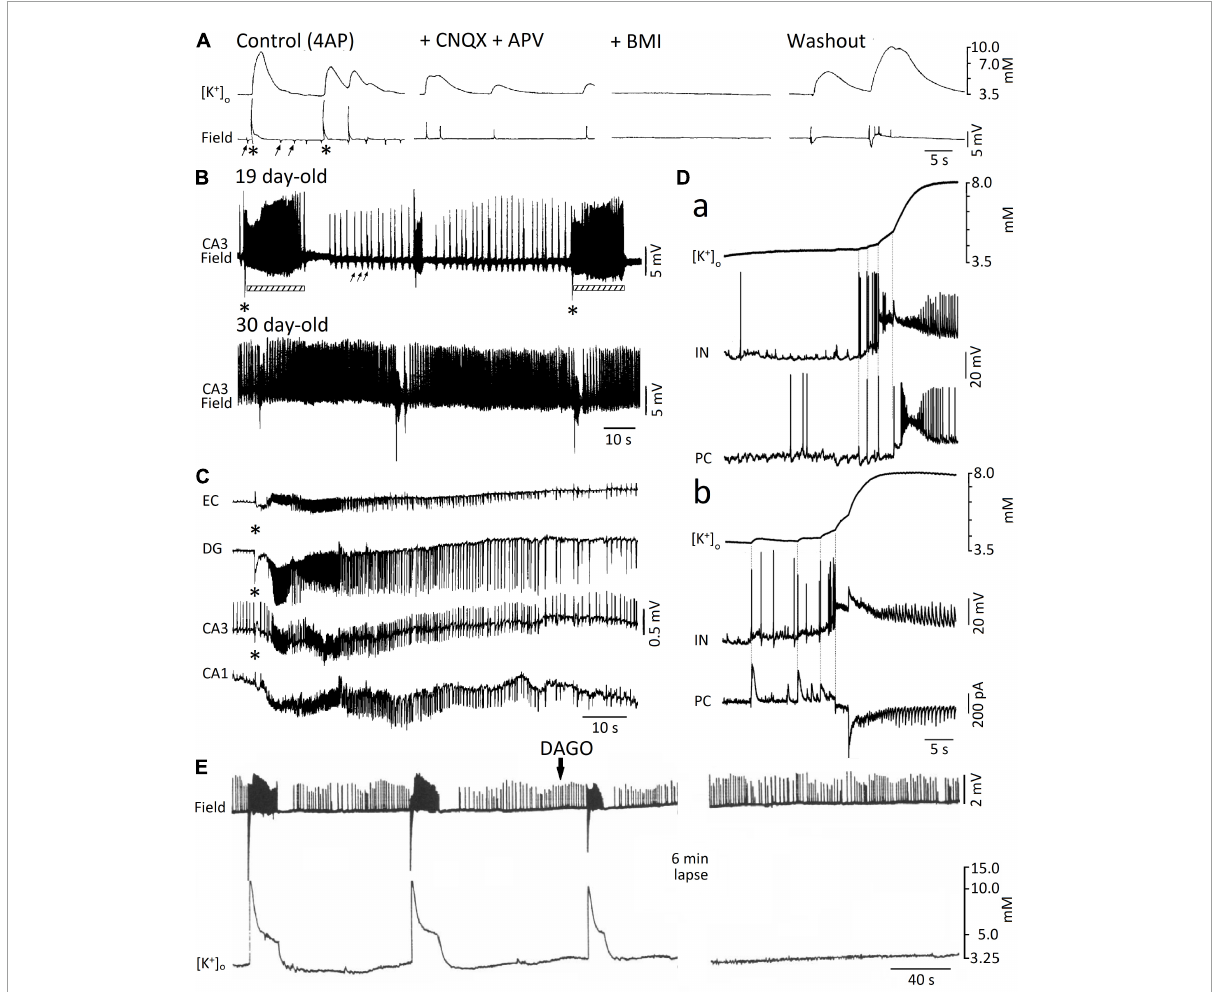
FIGURE3 (A) Simultaneous extracellular [K + ] and field potential recordings obtained from the CA1 subfield of an adult rat hippocampal slice during 4AP (Control) and successive application of ionotropic glutamatergic receptor antagonists (+ CNQX + CPP), GABA A receptor antagonist (BMI), and washout (i.e., return to 4AP application for over 3 h); note in control the occurrence of both “slow” (asterisks) and “fast” (arrows) interictal spikes as well as that only the “slow” spikes are associated with sizable increases in extracellular [K + ]. Note also that these “slow” spikes continue